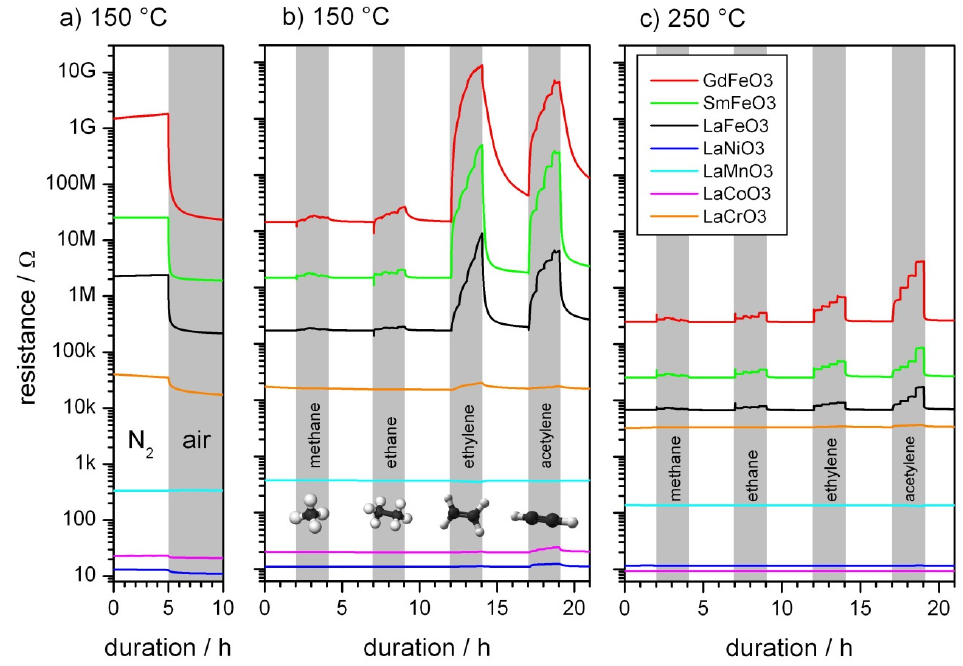
Figure 3. DC resistance measurements in dry air: ( a ) transition from nitrogen to air at 150 °C, ( b ) exposure different analyte gases at 150 °C, and ( c ) 250 °C. The shaded areas indicate periods, where the sensors were exposed to different concentrations of the analyte gases.